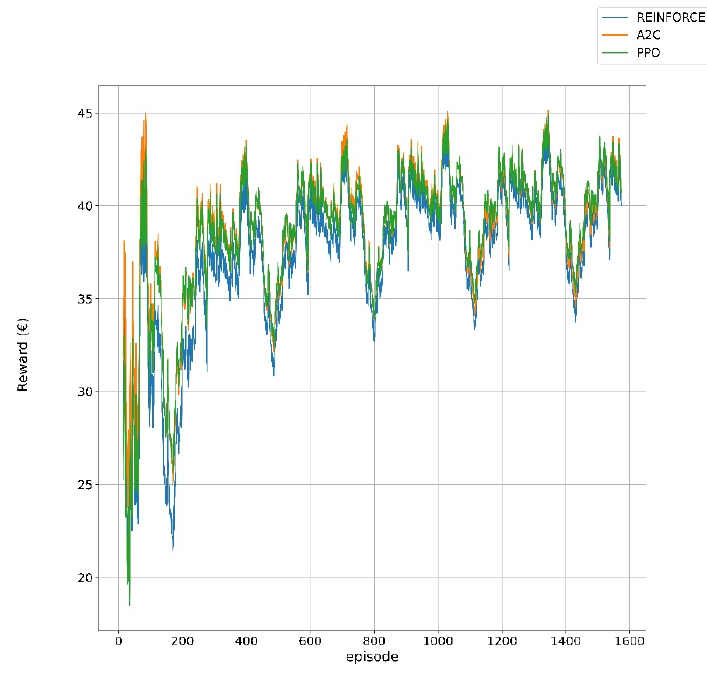
Figure 6. Training reward.